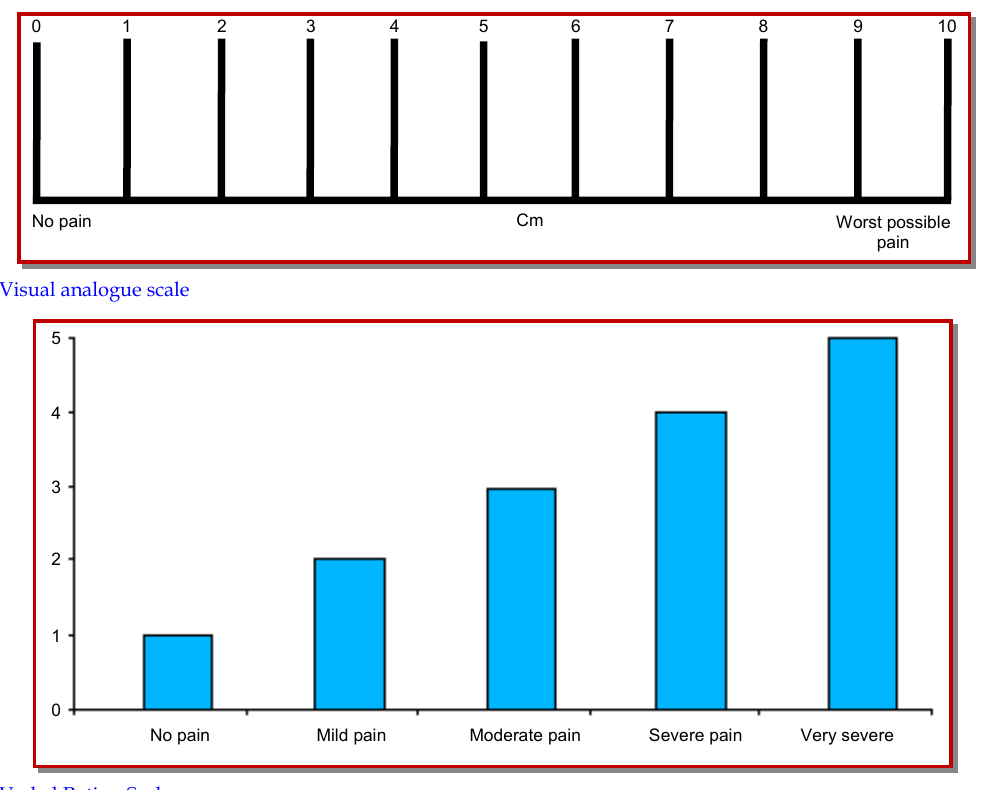
Figure 2: Verbal Rating